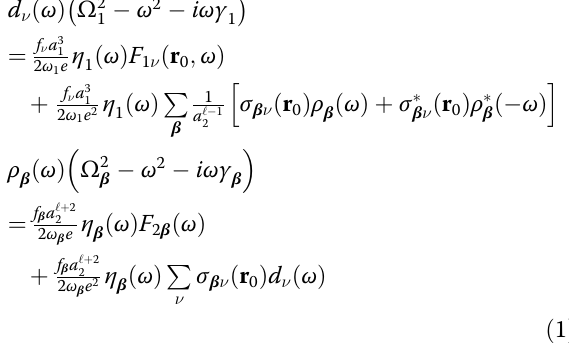
the likelihood that a photon will be exchanged between the and Au multiple times before being radiated away LiNbO 3 also